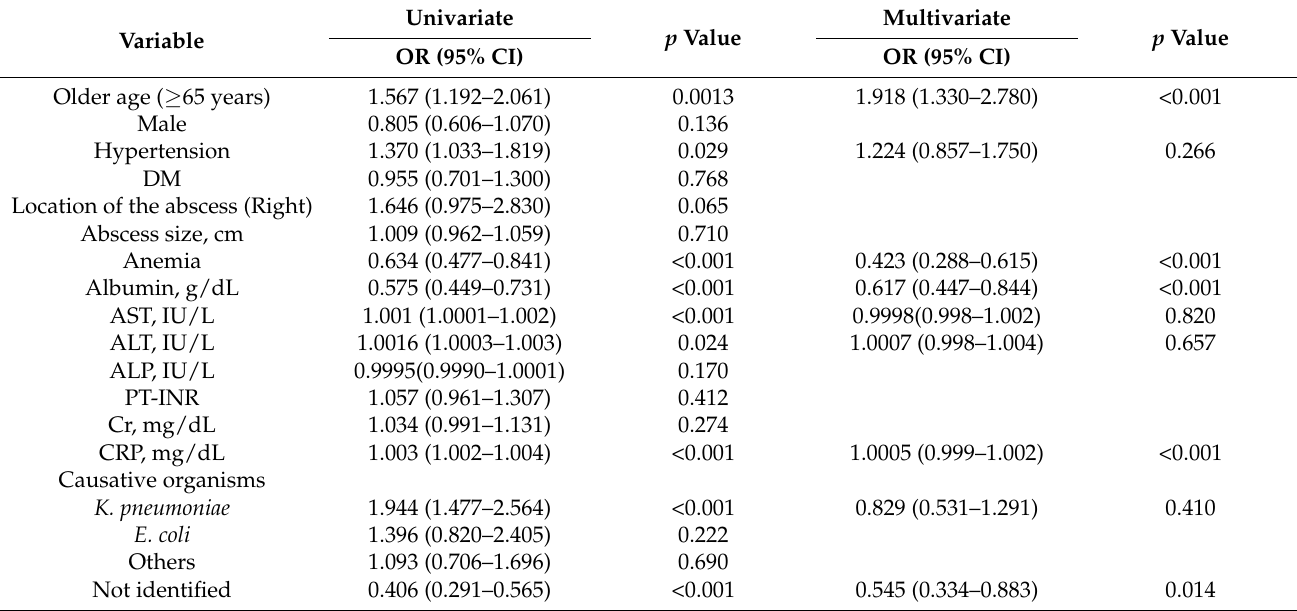
Table 2. Univariate and multivariate analyses of factors related to a low PWR in patients with PLA.